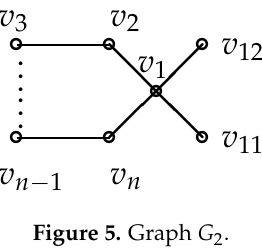
Figure 5. Graph G 2